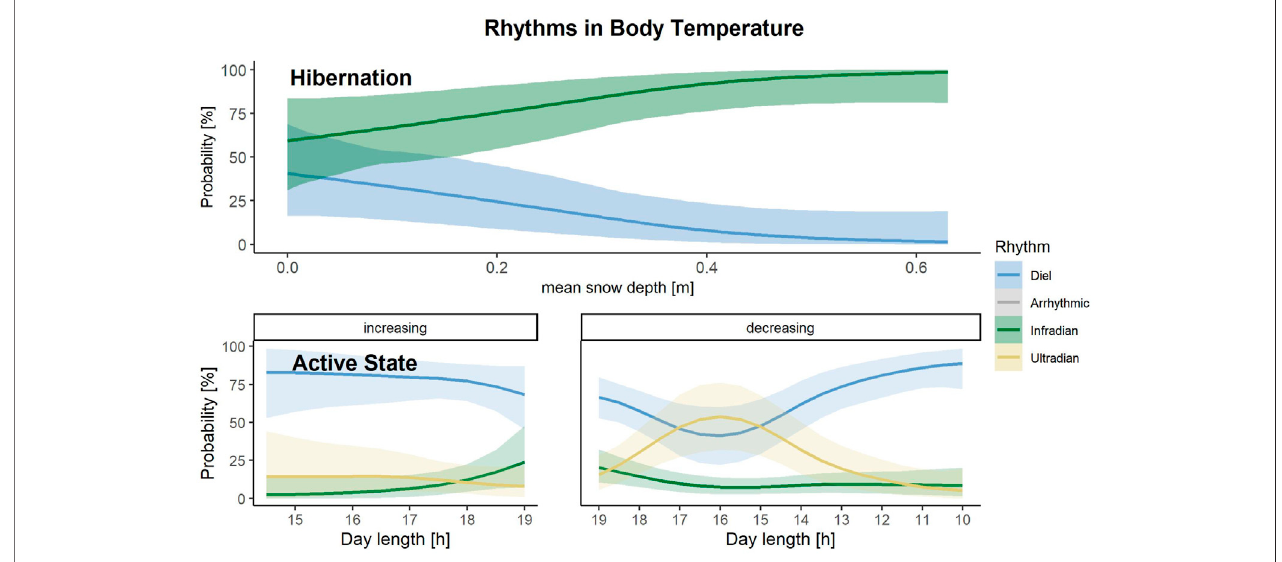
FIGURE7| Predictionsoftheprobabilitythateitheradiel(blue),infradian(green),ultradian(yellow)rhythminbodytemperatureisdisplayedbyScandinavianbrown bearsduringtheiractiveorhibernationstate,dependingonincreasingordecreasingdaylength[h]duringactivestateandsnowdepth[m]duringhibernationinthestudy area in south-central Sweden. Shaded areas indicate 95% credible